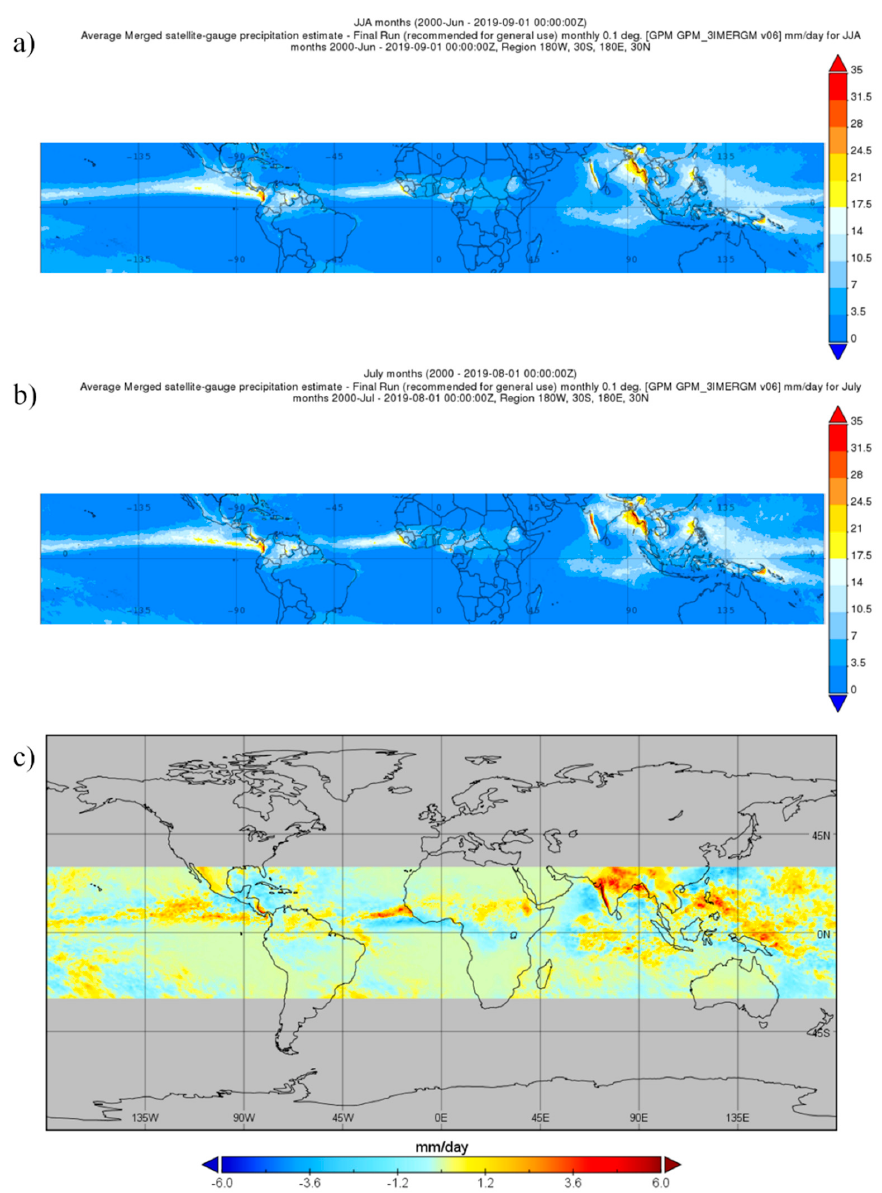
Figure 5. Monthly and seasonal IMERG Final Run precipitation maps (in mm / day) averaged during the period 2000– 2019 from Giovanni: ( a ) seasonal averaged map for June, July and August (JJA); ( b ) monthly averaged map for July; and ( c ) their differences (July minus JJA) in mm/day.